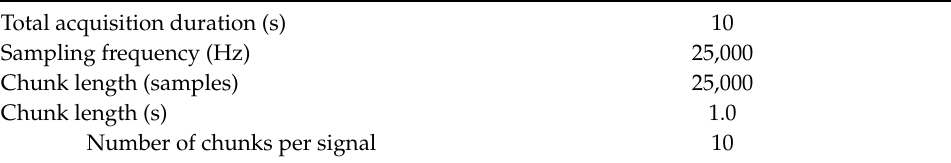
Table 5. Signal Table 5. Signal extraction.